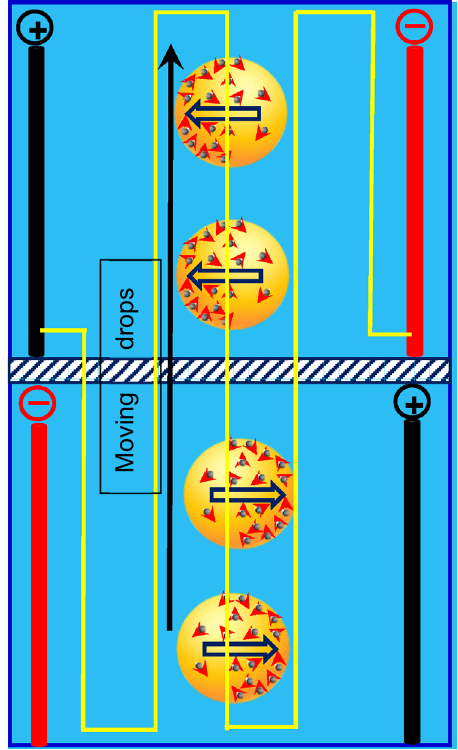
Figure 1. Schematic of nanofluid drops with effect of a pulsed electric field; Brownian and electro-induced motions are assigned with short and long